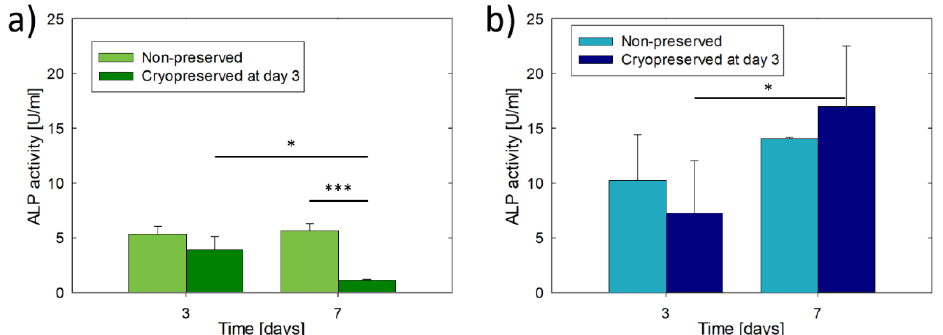
Figure 3. Alkaline phosphatase (ALP) activity of 3D-bioprinted osteoblast constructs with or without cryopreservation after 3 days of culture: ( a ) MG-63 constructs and ( b ) Saos-2 constructs. Asterisks indicate statistically significant differences at * p < 0.05, *** p < 0.001, n = 3.